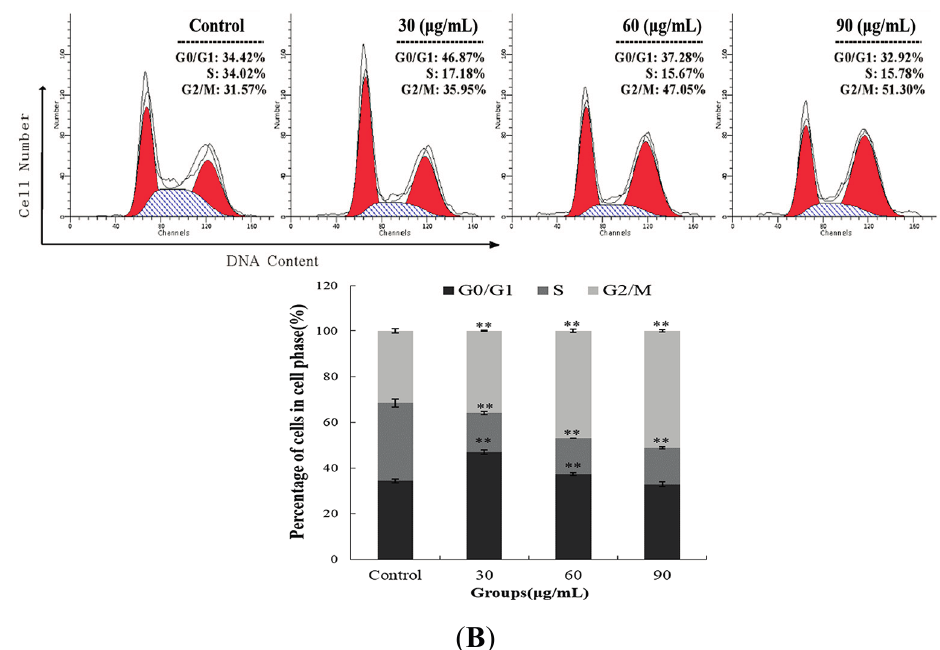
Figure 2. DNA damage and cell cycle arrest post M. integrifolia treatment. ( A ) Effect of M. integrifolia on DNA fragmentation of K562 cells. K562 cells were treated with M. integrifolia for 24, 48 and 72 h, then stained with propidium iodide (PI) and analyzed by fl ow cytometry; ( B ) Cell cycle analysis of M. integrifolia -treated cells. K562 cells were harvested and fixed in 70% alcohol and then stained with PI. Finally the stained cells were analyzed using a flow cytometer. ** p < 0.01 vs. Control. (Error bars = S.D., n =